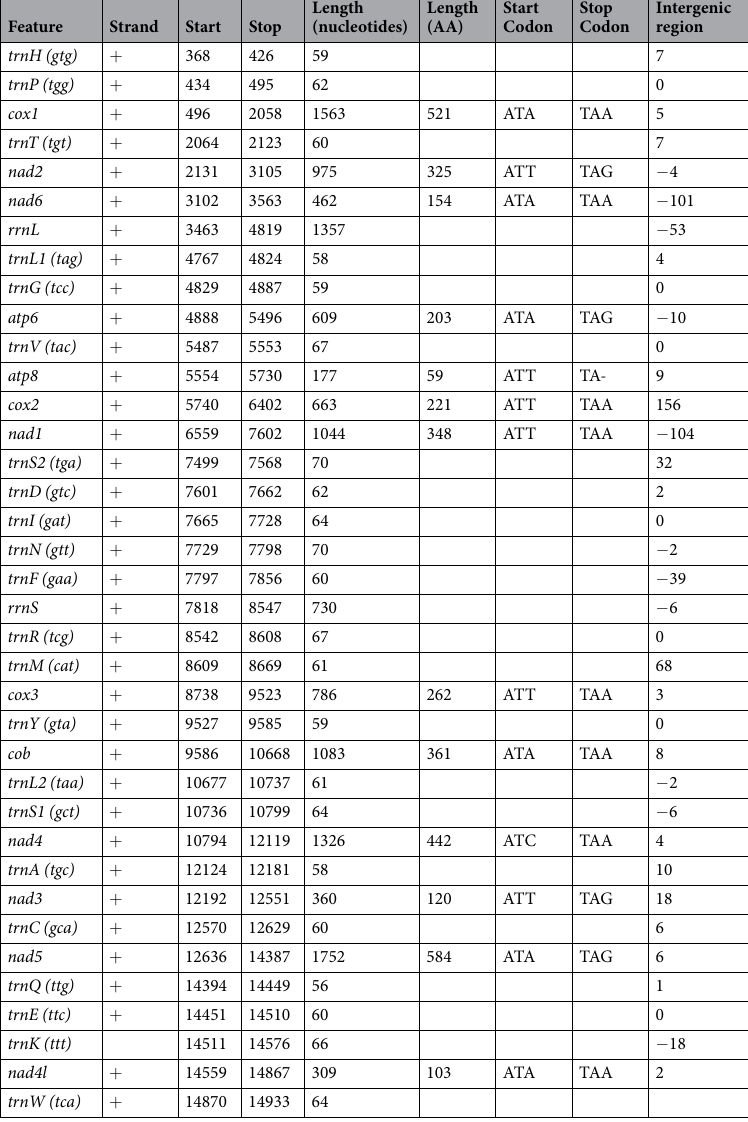
Table 1. Organisation of the Paratomella rubra 14.9 kb mitochondrial genome sequence. All genes found on the ‘positive’